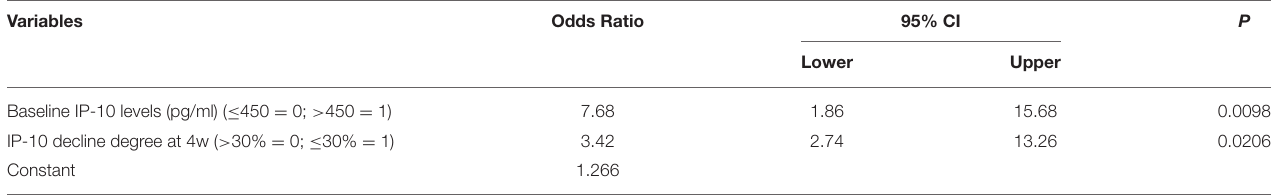
TABLE 3 | Risk factors affecting SVR in HCV-infected patients with DAAs treatment.